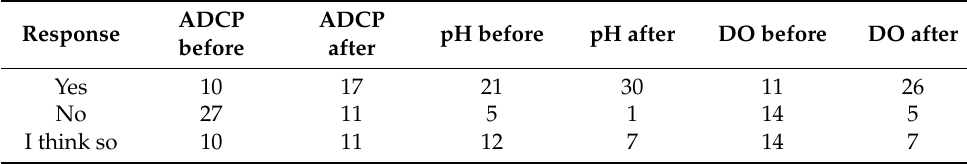
Table 3. Student knowledge of what sensor is (ADCP, pH, and DO).